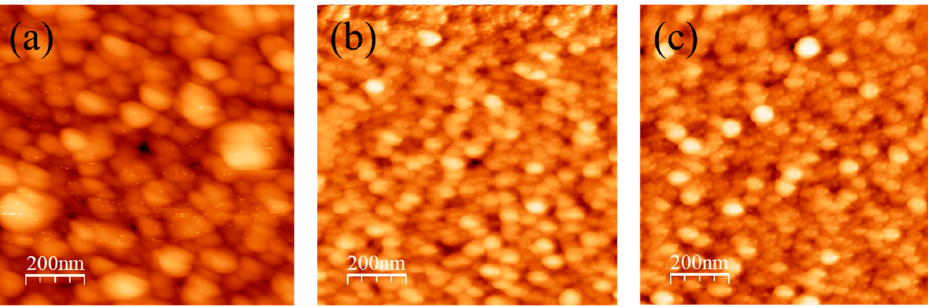
Figure 6. Two-dimensional AFM images of AlN thin films deposited using RF sputtering with N 2 flow rates of ( a ) 20, ( b ) 30, and ( c ) 40 sccm.